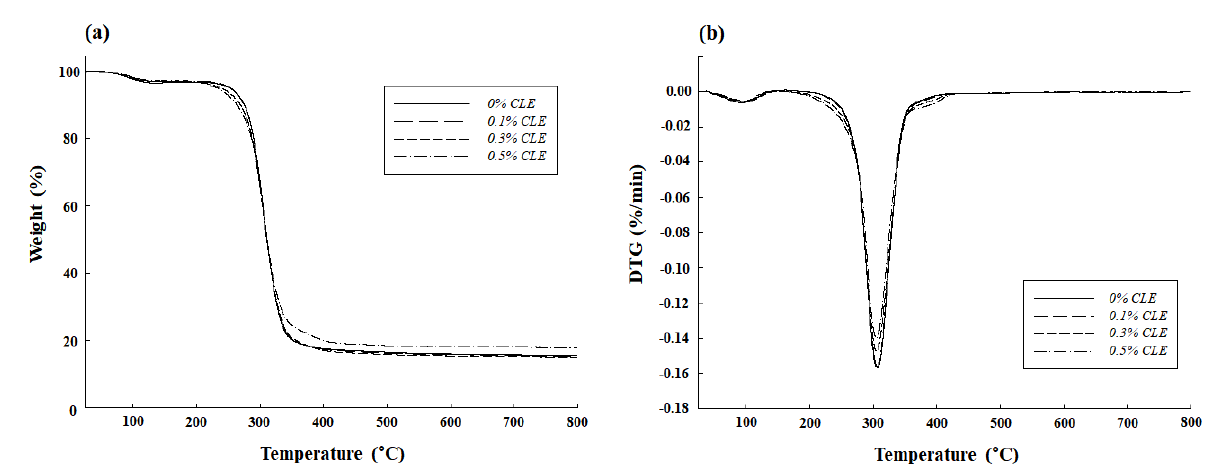
Figure 3. Thermal stability of GBS films containing CZEO. ( a ) TGA, ( b ) DTGA.